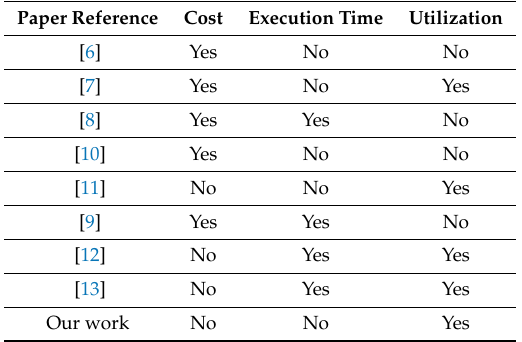
Table 1. Summary of related papers, based on the metrics used to evaluate resource